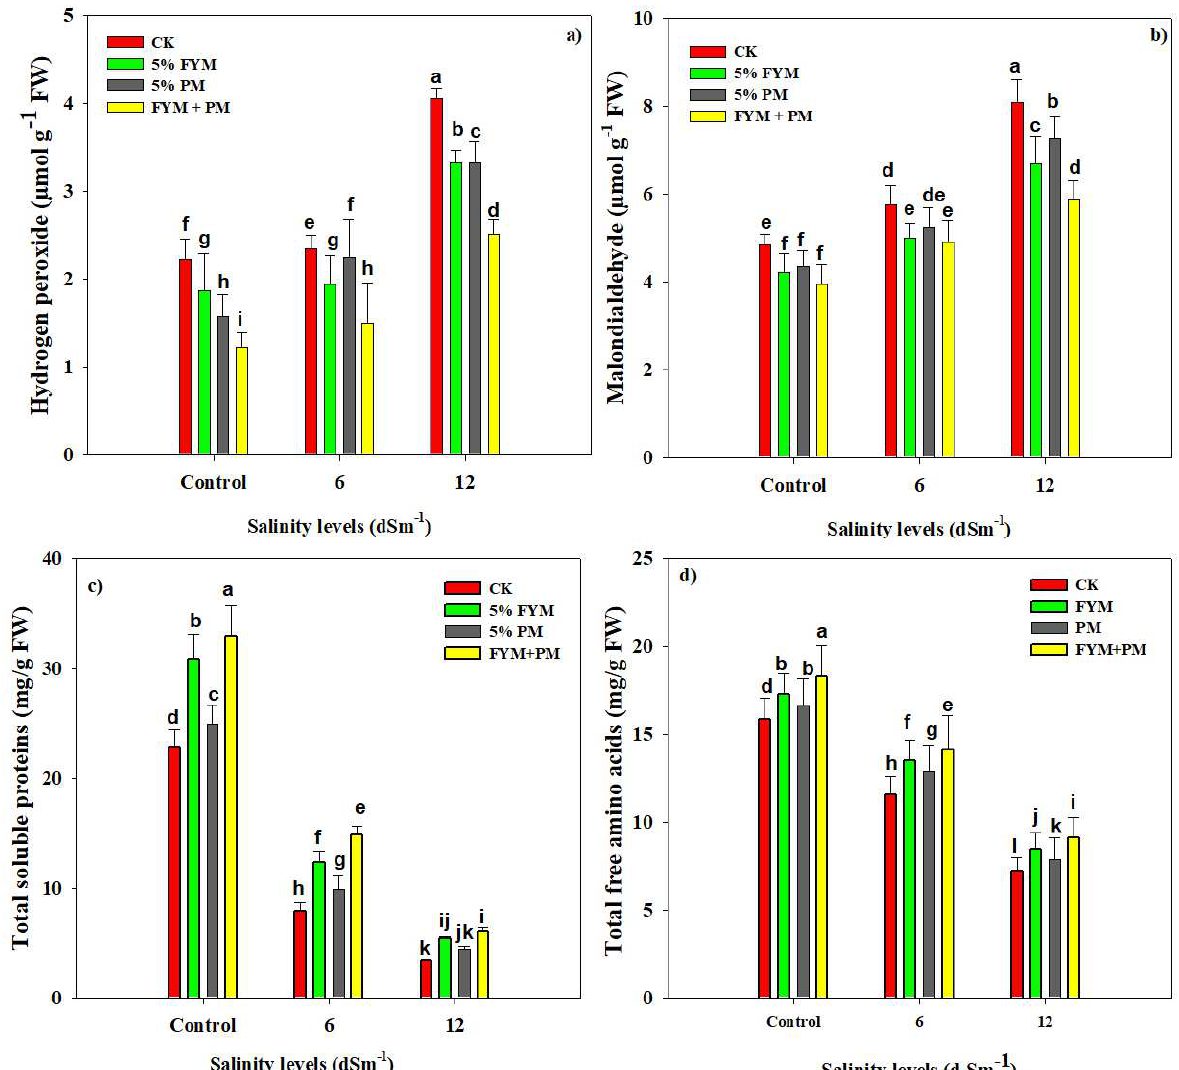
Figure 2. Effect of different organic amendments on H 2 O 2 ( a ) MDA ( b ), TSP ( c ), and FAA ( d ) under diverse leaves of salinity stress. The bars are means of four replicates with ± SE while diverse letters indicate significant differences at p <